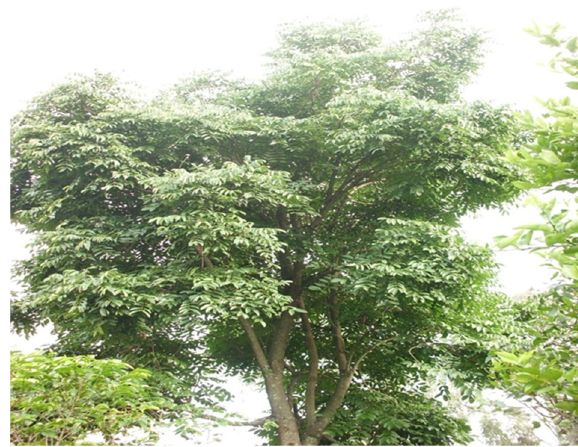
Fig. 4 A tree that protects the Enset plant from the